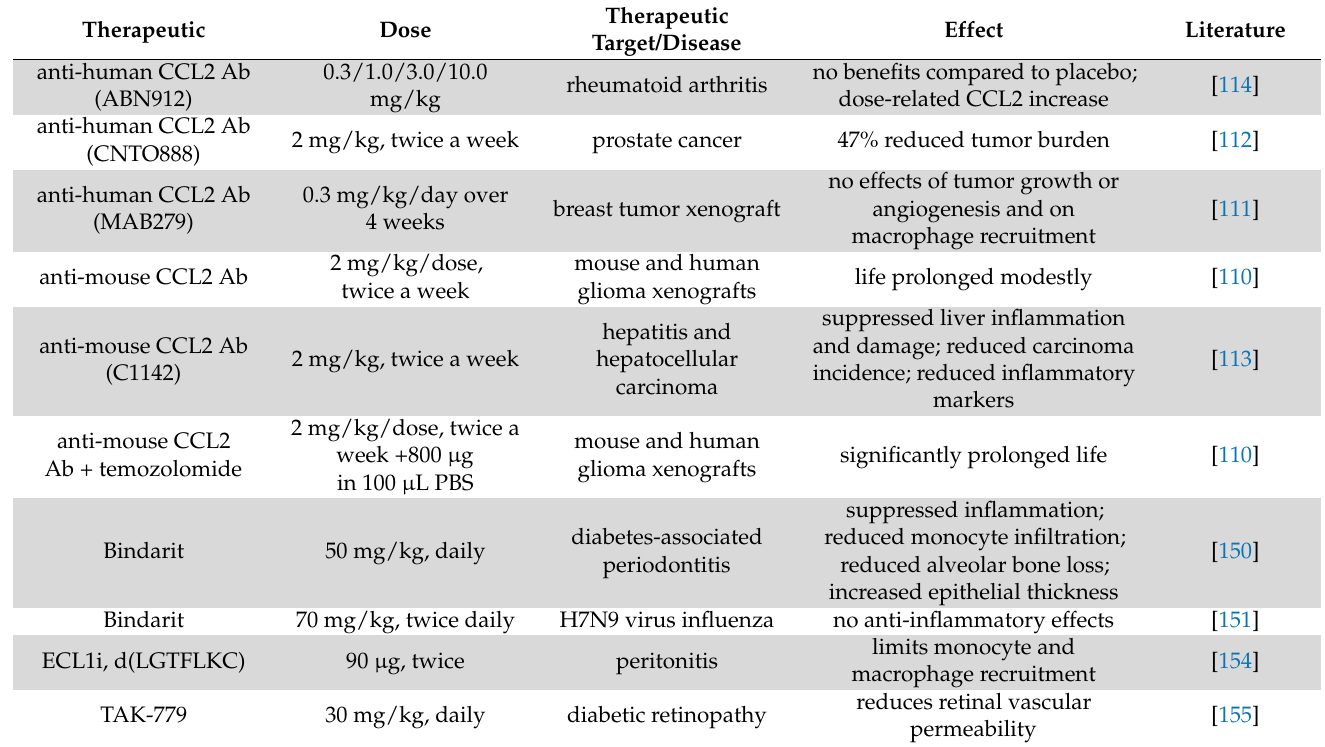
Table 1. Potential for CCL2 as a drug target to treat inflammatory, cardio-metabolic, and distinct malignant disease in the future. As of January 2021, no specific CCL2-targeting treatment has been approved by responsible legal authorities. Therapeutic Therapeutic Dose Target/Disease